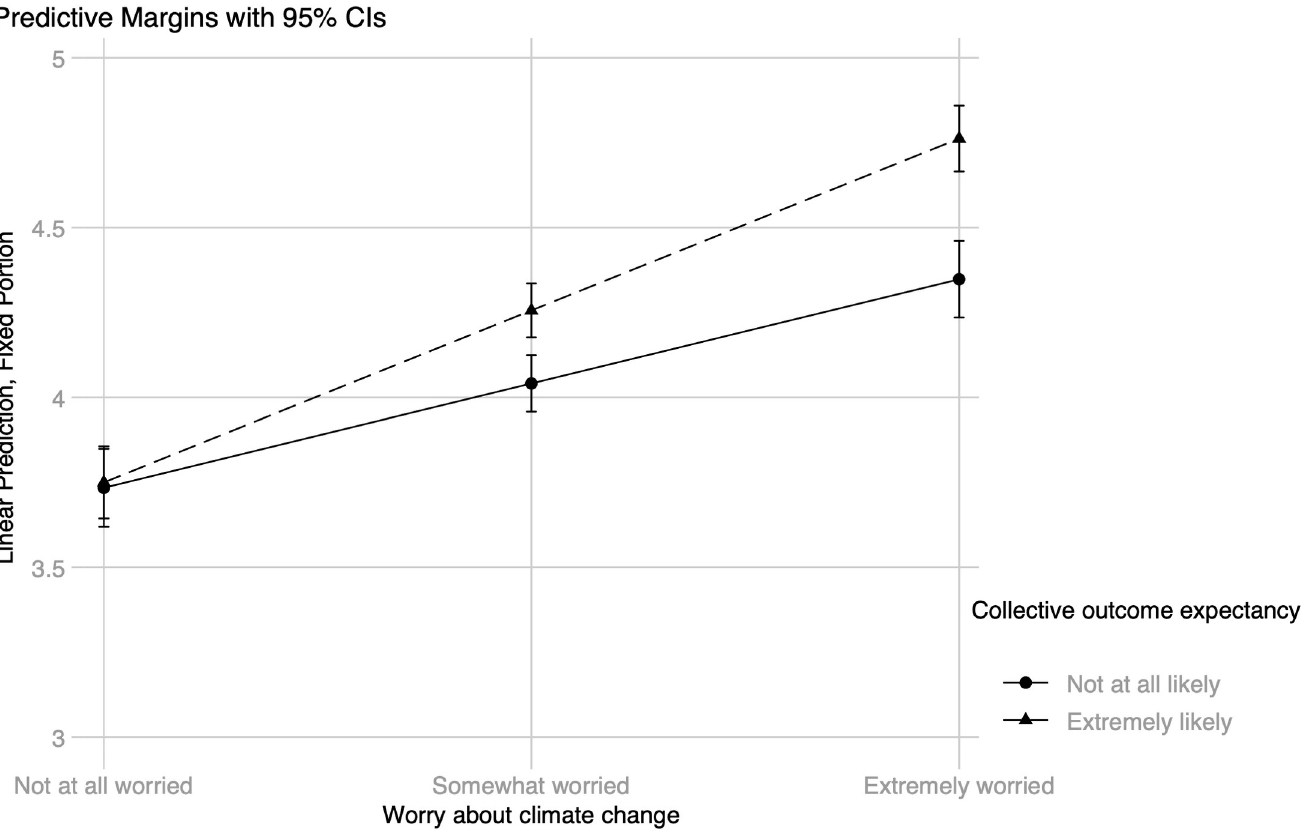
Fig 4. Energy curtailment behavior: Worry about climate change × collective outcome expectancy.